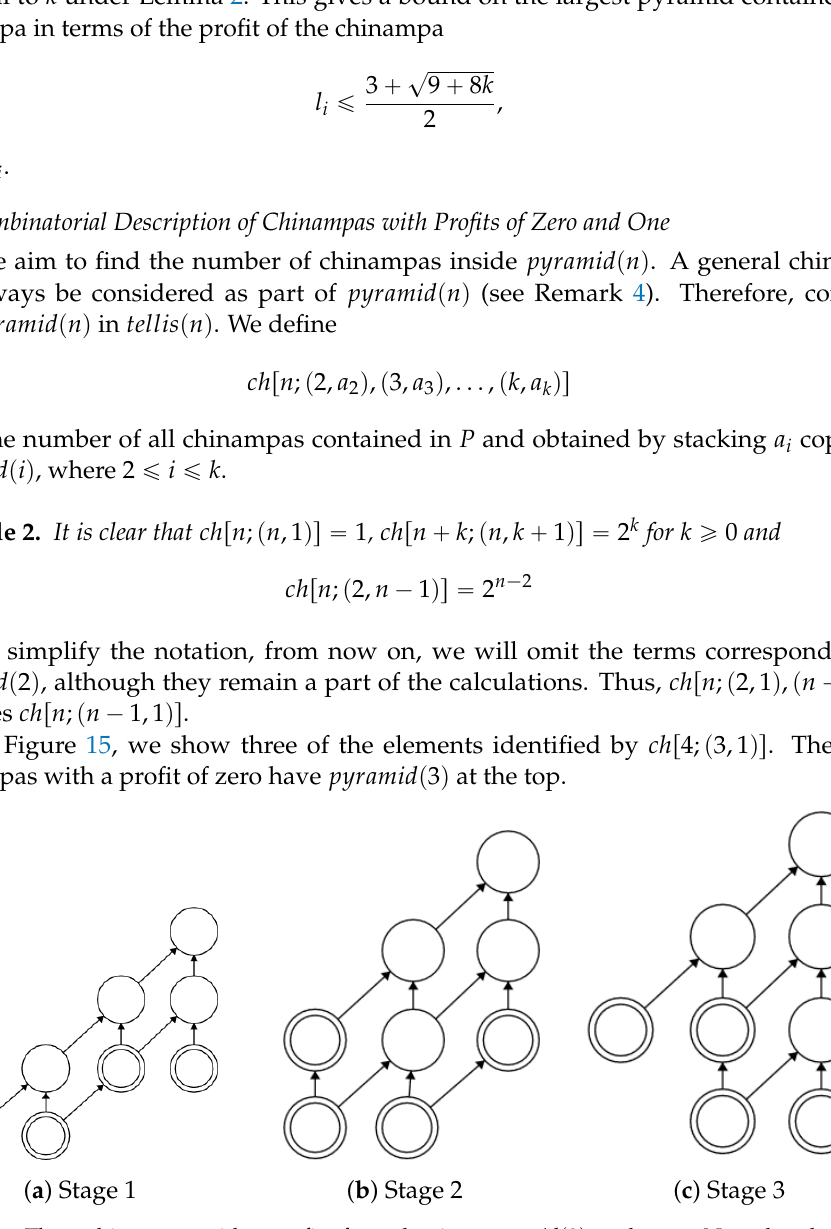
Figure 15. Three chinampas with a profit of zero having pyramid p 3 q at the top. Note that the stages were obtained from pyramid p 3 q , replacing one of the three primary vertices v at a time of zero by two primary vertices at the time ´ 1 so that v becomes a secondary